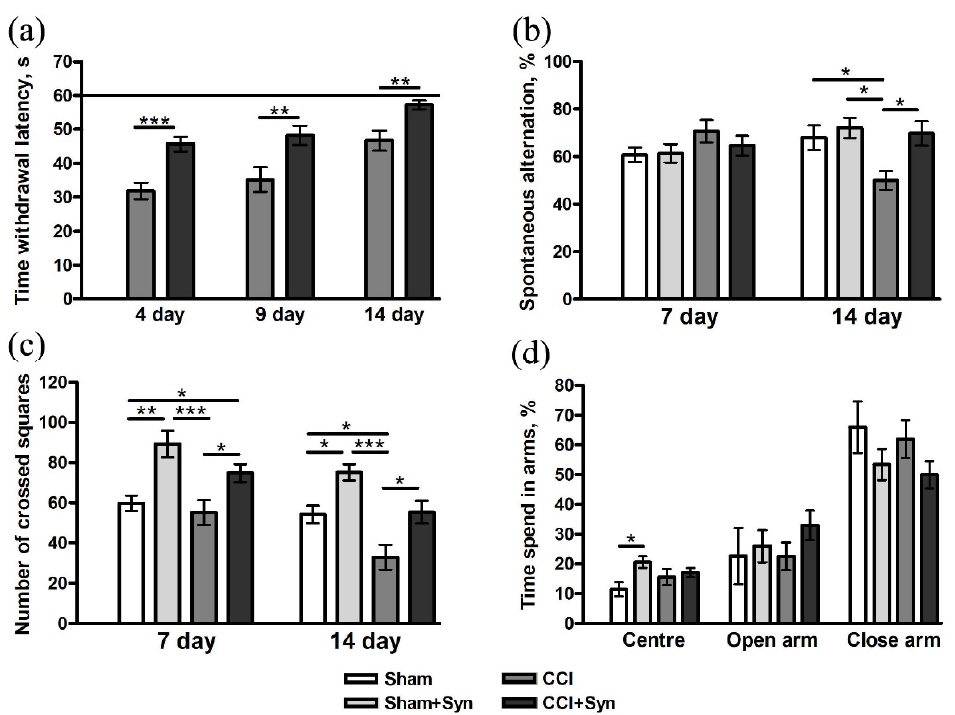
Figure 2. Behavioral effects of CCI and synaptamide treatment. ( a ) Dynamics of the latency period for reaction to thermal stimulus. ( b ) Spontaneous alternation rate differences in Y-maze testing. ( c ) Locomotor activity: the number of crossed squares in the open-field test. ( d ) Anxiety-like behavior testing with the elevated plus-maze (EPM). Data are presented as mean ± SEM, n = 19/group, * p < 0.05, ** p < 0.01, and *** p < 0.001 (one-way ANOVA, post-test Tukey).